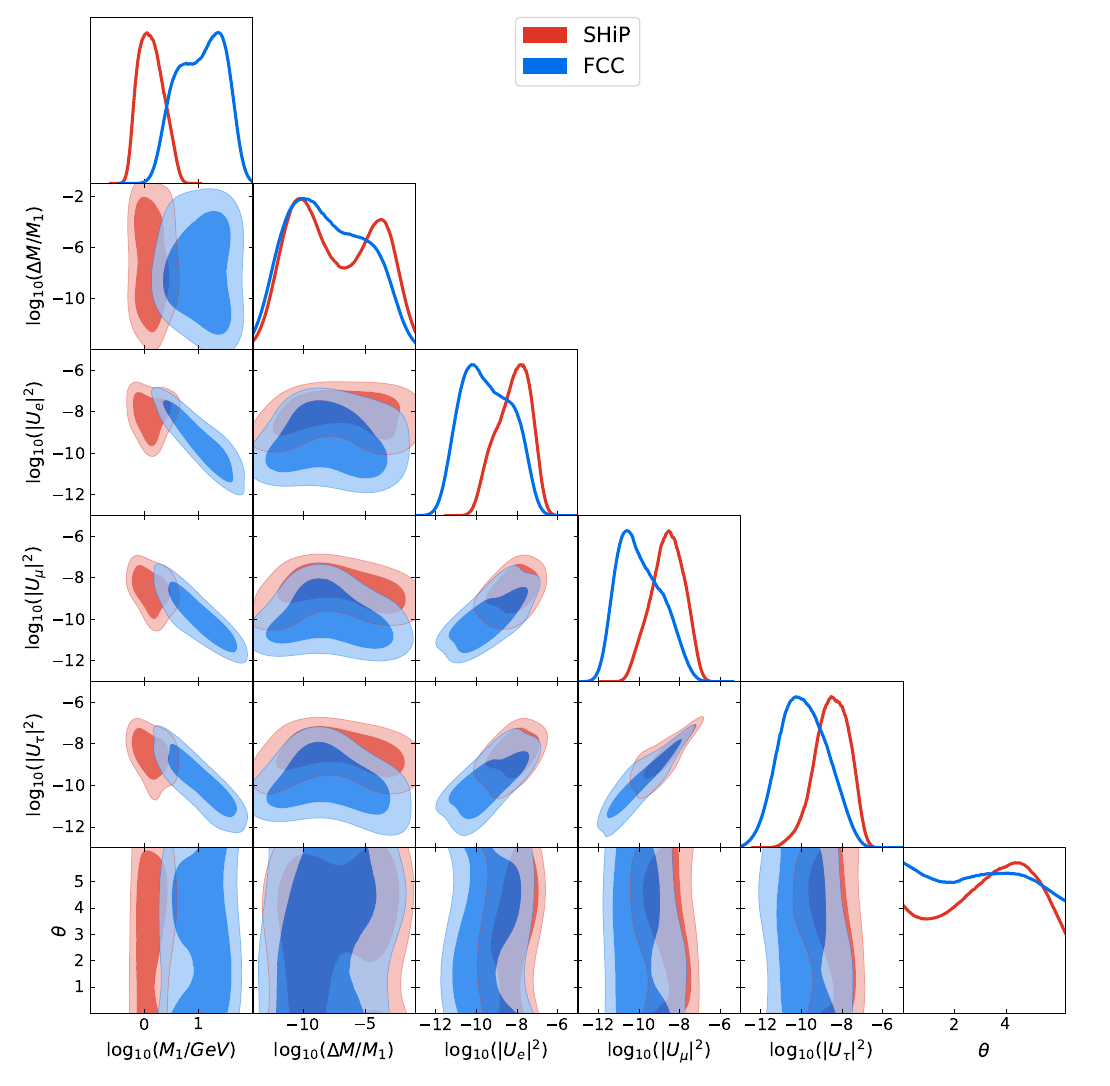
Figure 20 . Same as in figure 19 but for